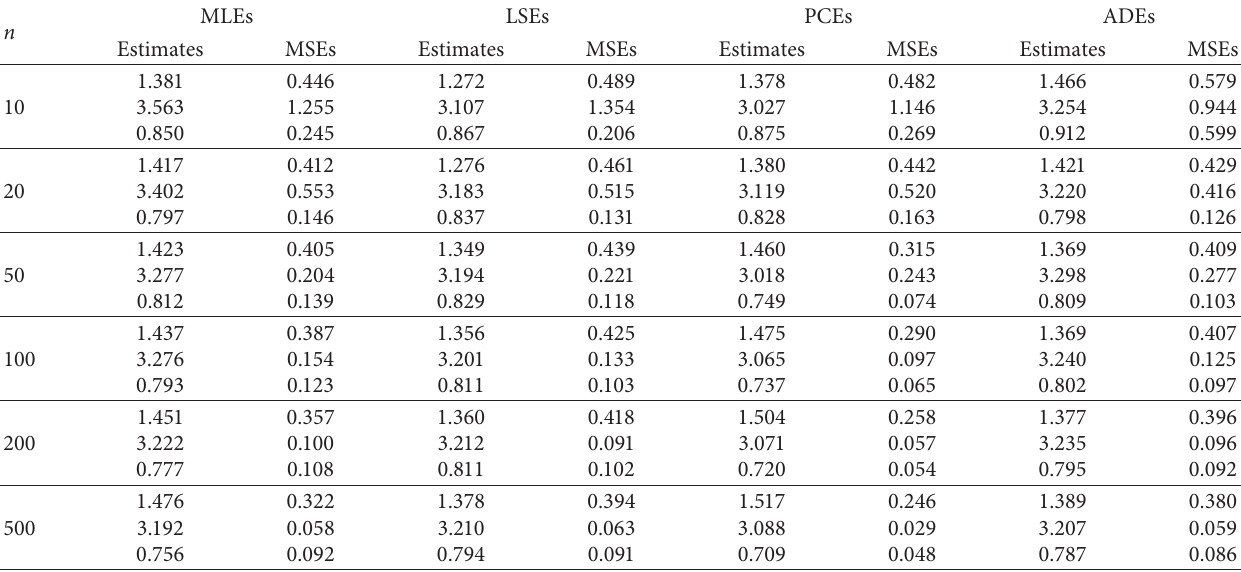
Table 3: Estimates and MSEs of the OFIL distribution for MLEs, LSEs, PCEs, and ADEs for set 2 ( α � 2, θ � 3, and β � 0.5). MLEs LSEs PCEs ADEs n Estimates